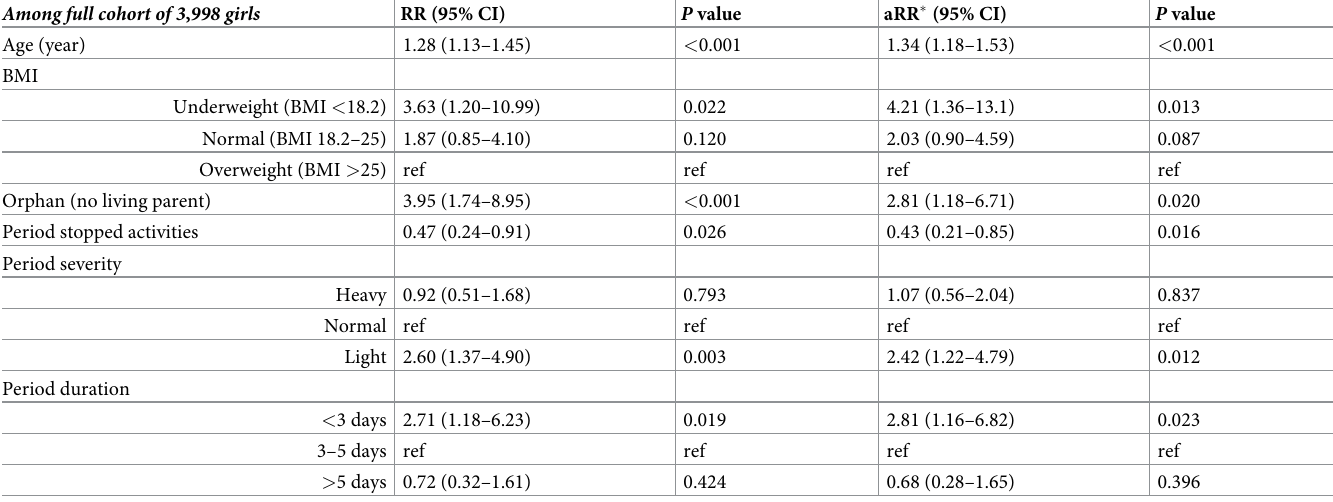
aRR, adjusted risk ratio; BMI, body mass index; CI, confidence interval; RR: Risk